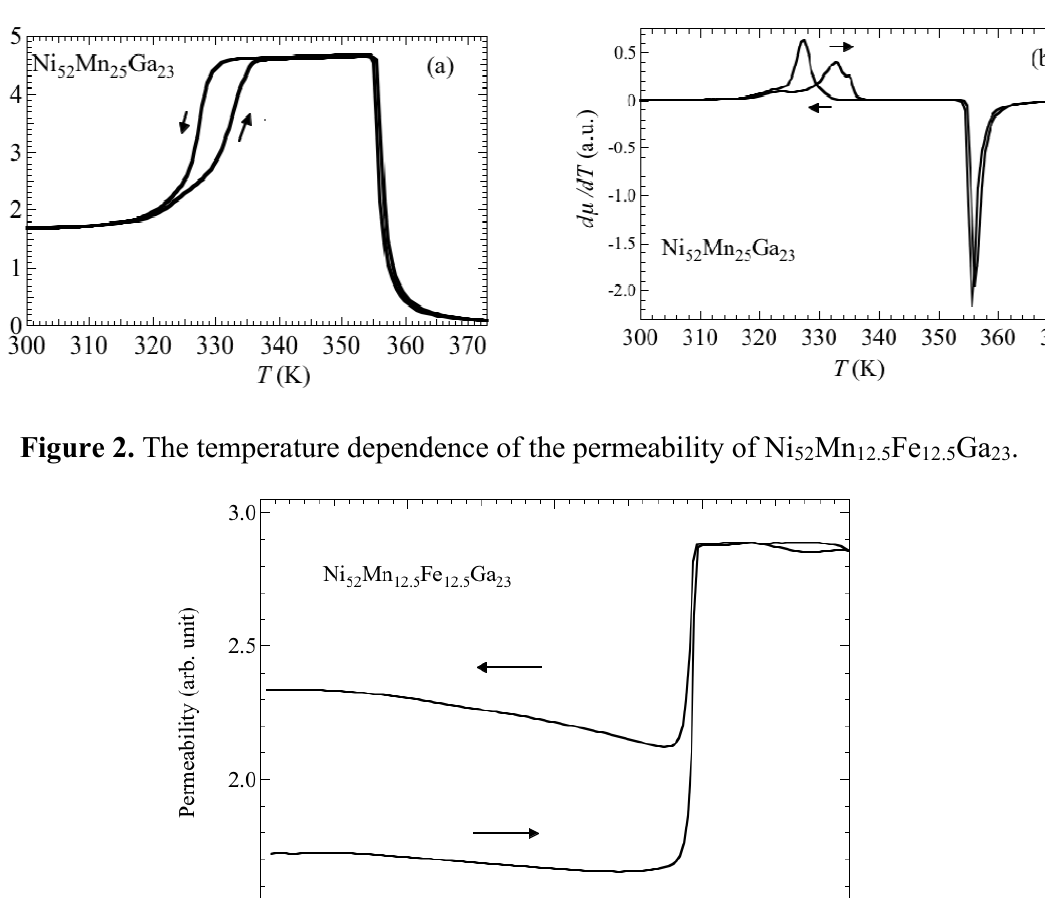
Figure 1. ( a ) Temperature dependence of the permeability of Ni dependence of the differential of the permeability.